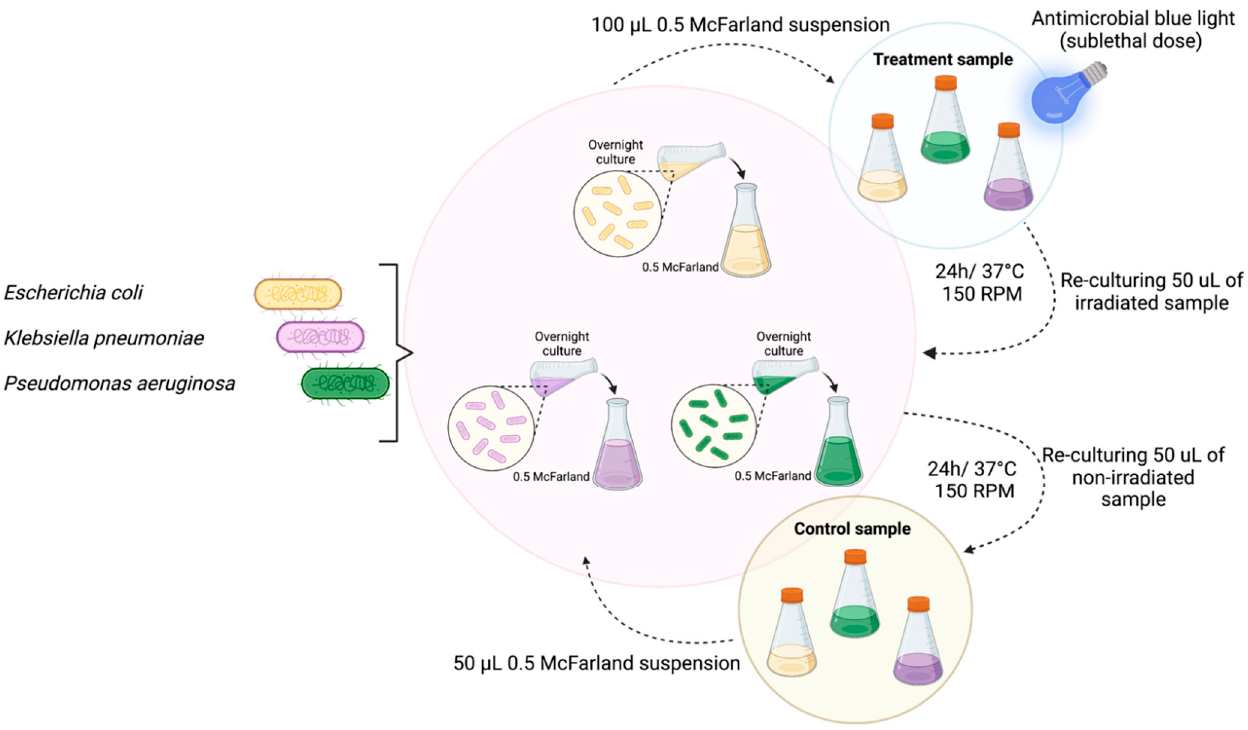
Figure 8. Experimental workflow. All Gram-negative representative bacteria ( E. coli , K. pneumoniae , and P. aeruginosa ) were inoculated and cultured at 37 °C in LB medium for 16–20 h. The cultures were diluted to an OD of 0.5 McF, and 100-µL bacterial suspension samples were irradiated with 415 nm light at light doses close to the MDK 99 . Following exposure, 50 µL of the treated suspension was transferred into fresh LB medium (5 mL) to regrow overnight. The next day, after 16–20 h of incubation, the treatment was repeated under the same conditions. The cycle of exposure—regrowth—exposure was repeated 15 times. Control groups represent the cells that were not treated with blue light but passaged daily. Subsequently, all of the samples that originated from the 1st, 5th, 10th, and 15th cycles were tested for potential tolerance development.